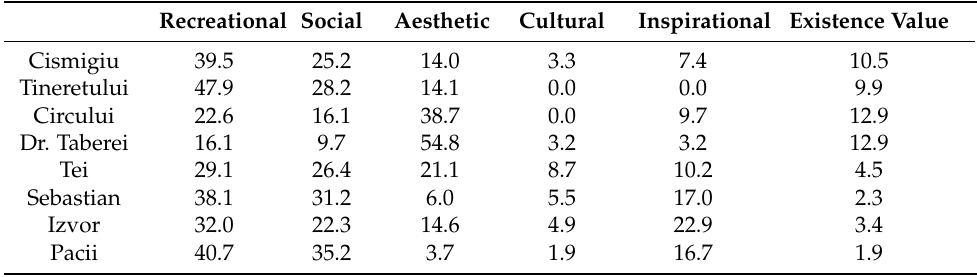
Table 5. The main activities carried out in selected parks as reflected on Instagram posts. Recreational